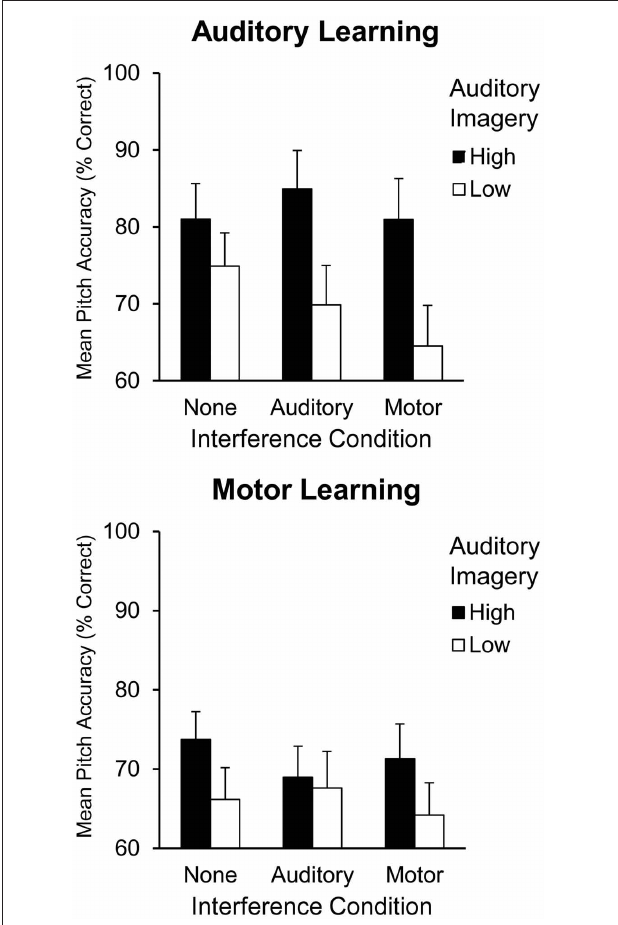
FIGURE 2 | Mean pitch accuracy (% correct pitches) during Recall by auditory imagery group, learning condition, and interference condition in Experiment